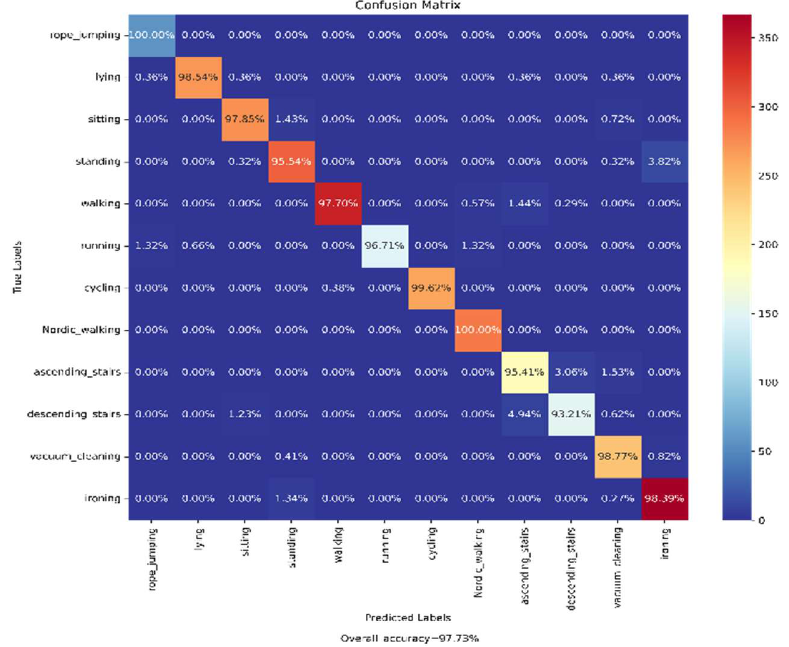
Figure 14. Confusion matrix achieved from the evaluation of our proposed Ensem-HAR model over the PAMAP2 dataset.